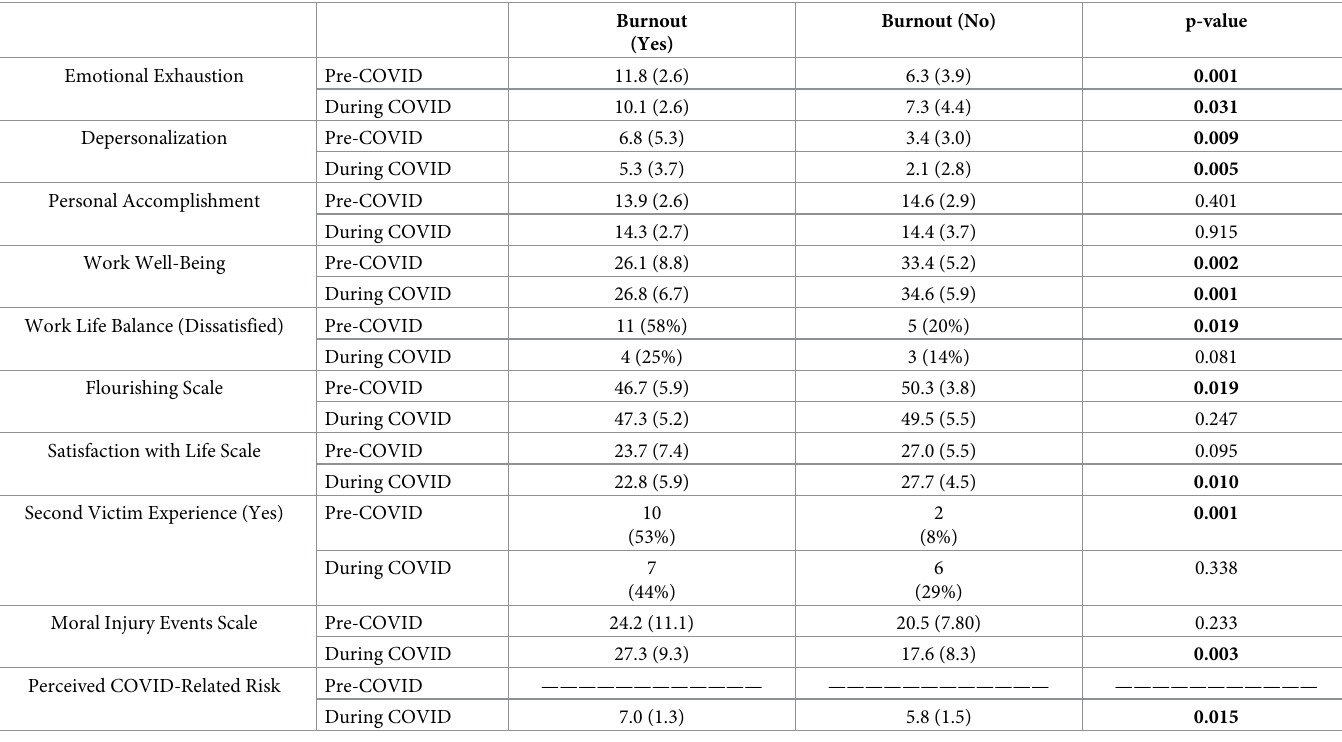
Table 3. Comparison of hospitalists with and without burnout pre and during COVID-19.